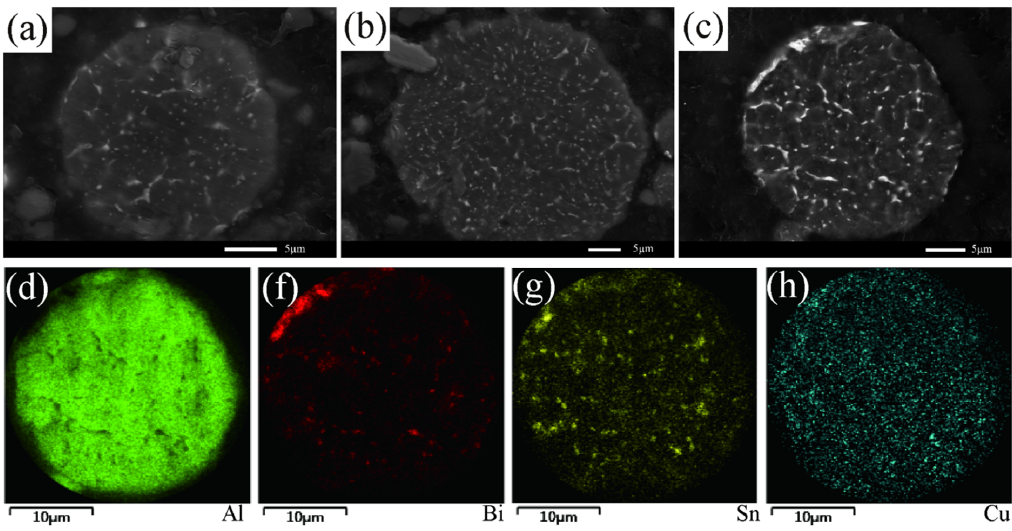
Figure 4. ( a – c ) SEM images of the cross-sections of Al–Bi–Sn–Cu powders: ( a ) Figure 4. (a–c) SEM images of the cross-sections of Al–Bi–Sn–Cu powders: (a) Al–10Bi–7Sn–0.5Cu, (b)